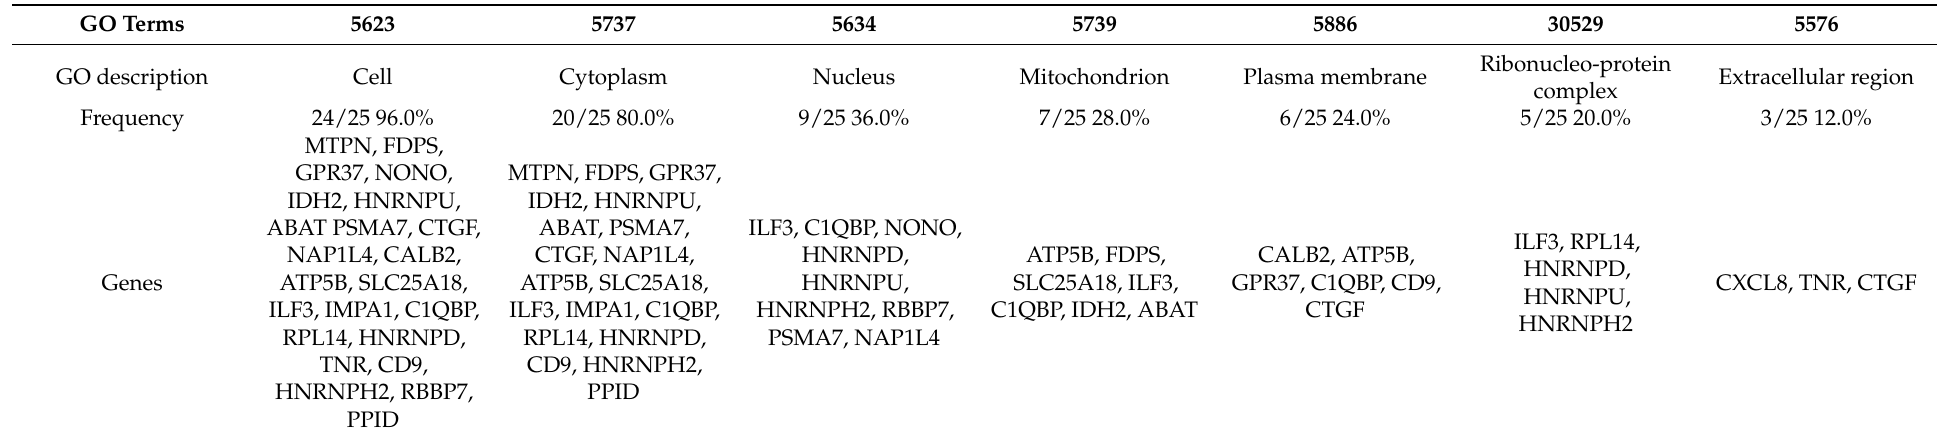
Table 2. Gene Ontology analysis. Sorted by cellular component.